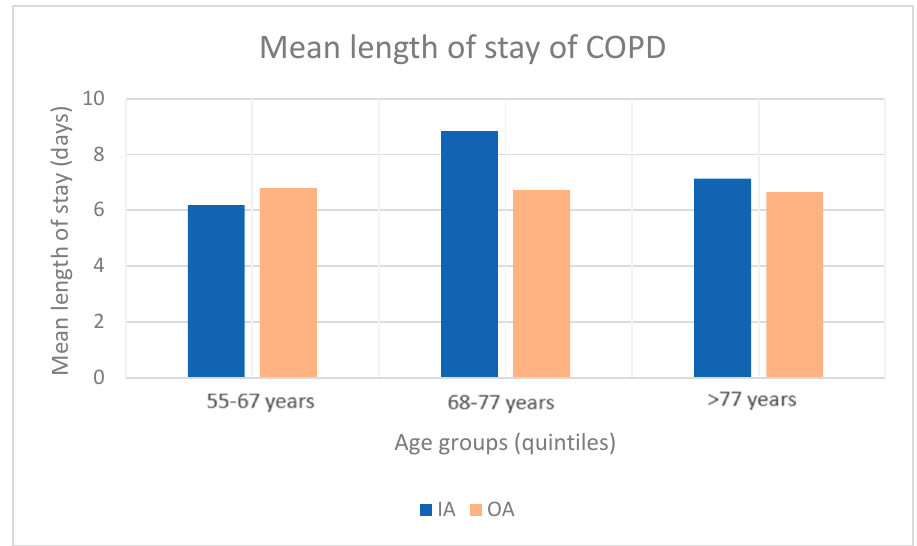
Figure 3. Comparison of the mean length of stay of COPD, IA and OA (2018–2021).